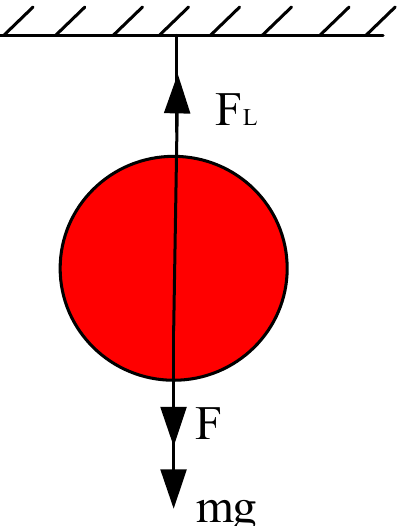
Figure 8. Stress analysis of Camellia oleifera fruits. F is the vibration load; F L is the binding force of the branch to the fruit; m is the weight of the fruit; a is the acceleration; and g is the acceleration caused by the earth’s gravity.